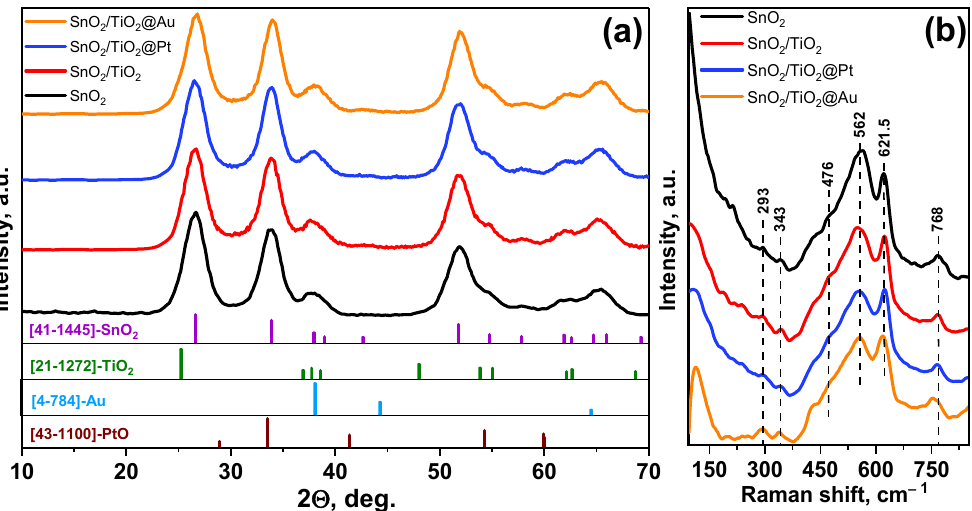
Figure 1. XRD patterns ( a ) and Raman spectra ( b ) of nanocomposites. Figure 1b represents Raman spectra of the synthesized samples. All spectra have almost the same peaks at the same positions, which mean no phase transition during synthesis process. The peaks detected at 476, 621.5 and 768 cm − 1 correspond to the SnO